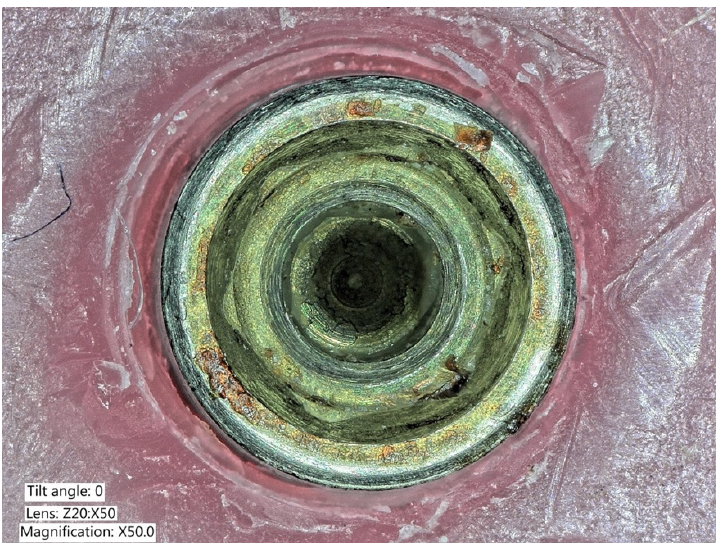
Figure 8. Explanted implant with a hexagonal connection. The implant crown was removed. The implant connection at microscope evaluation showed wear, signs of corrosion, and titanium particles.